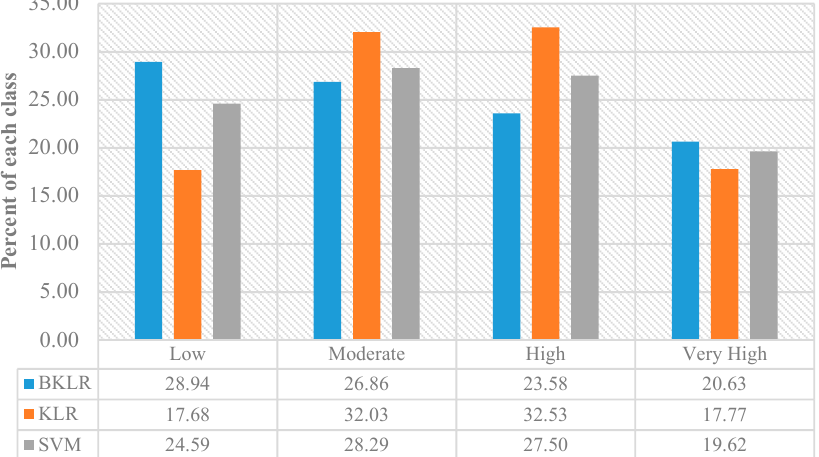
Figure 7. Landslide susceptibility map using the support vector machines (SVM) model.